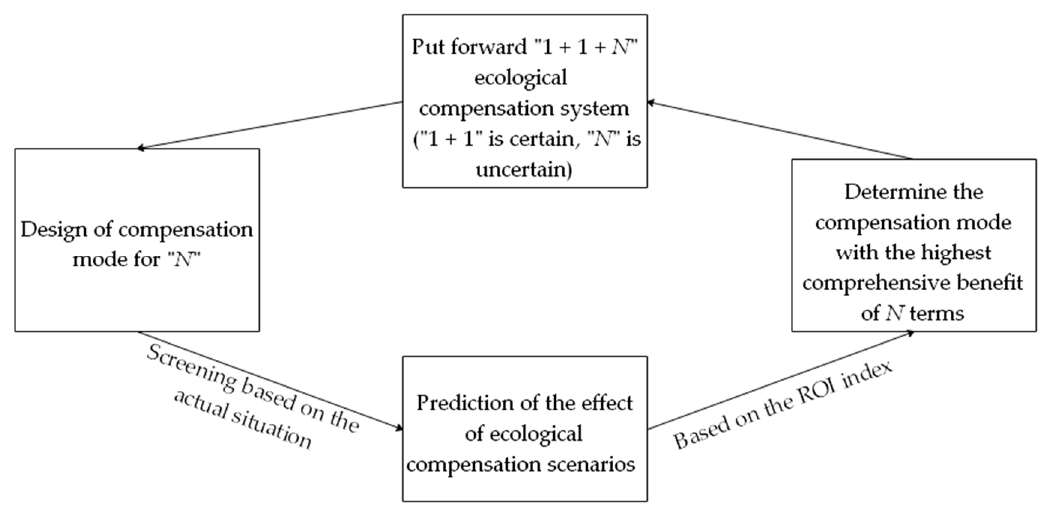
Figure 2. The specific model work flow chart.